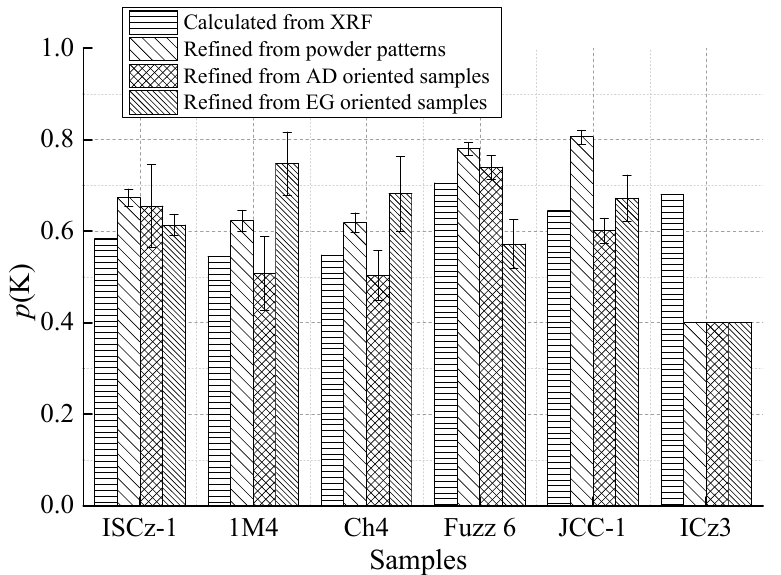
Figure 7. Refined values of occupancy of potassium p (K), compared to the values obtained by the XRF analysis.